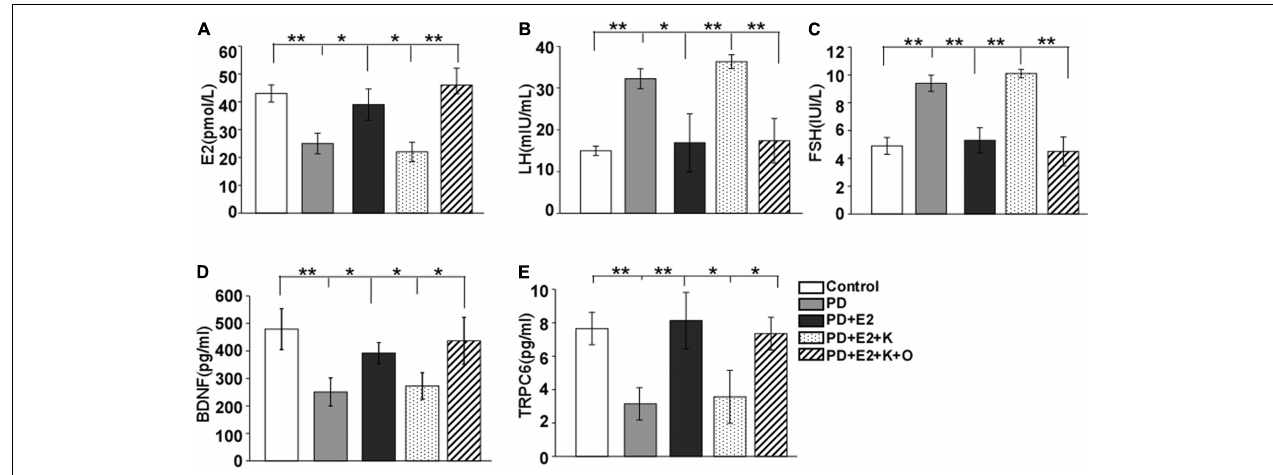
FIGURE 2 | Changes in the E 2 (A) , LH (B) , FSH (C) , BDNF (D) , and TRPC6 (E) levels in serum in all experimental groups ( n = 7, each group). Results are presented as mean ± SEM. * p < 0.05; ** p < 0.01.